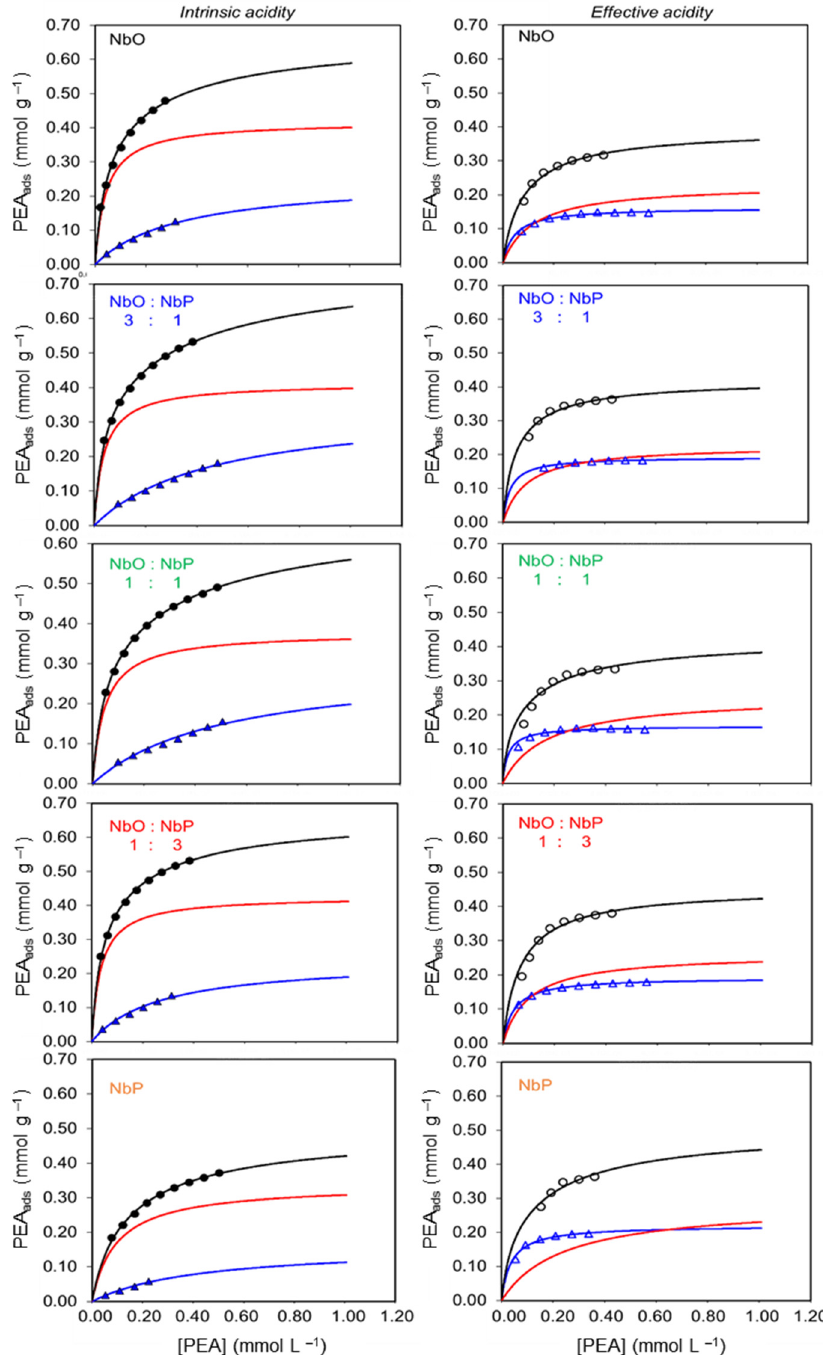
Figure 3. Adsorption isotherms at 30 °C of PEA probe on Nb-based samples evaluated in cyclohexane (left, full markers) for measuring the intrinsic acidity and in water-isopropanol solution (80:20 v/v ), (right, empty markers) for the effective acidity. Calculated Langmuir curves of I° run PEA adsorption (total acid sites), black lines; calculated Langmuir curves of the II° run PEA adsorption (weak acid sites), blue lines; calculated Langmuir of the strong acid sites, obtained from difference from the I° and II° PEA adsorptions, red curves.